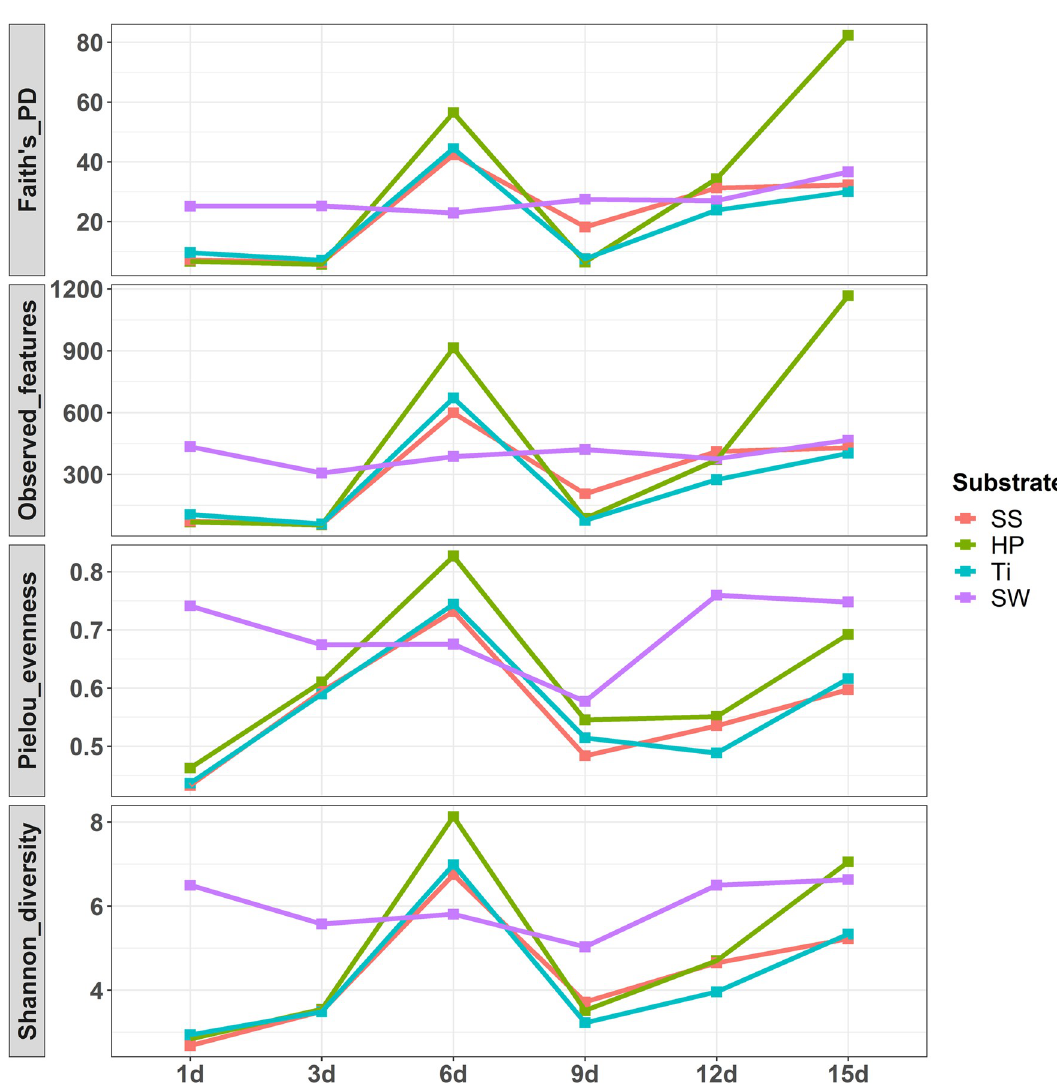
Fig 2. Alpha diversity indices of biofilm-forming and seawater-associated bacterial communities. Images displaying diversity, richness, and evenness of marine biofilms assembled on three artificial substrata viz., stainless steel (SS), titanium (Ti) and high- density polyethylene (HP) and peripheral seawater (SW) collected during day-1 to day-15 from the southern coastal region of India.